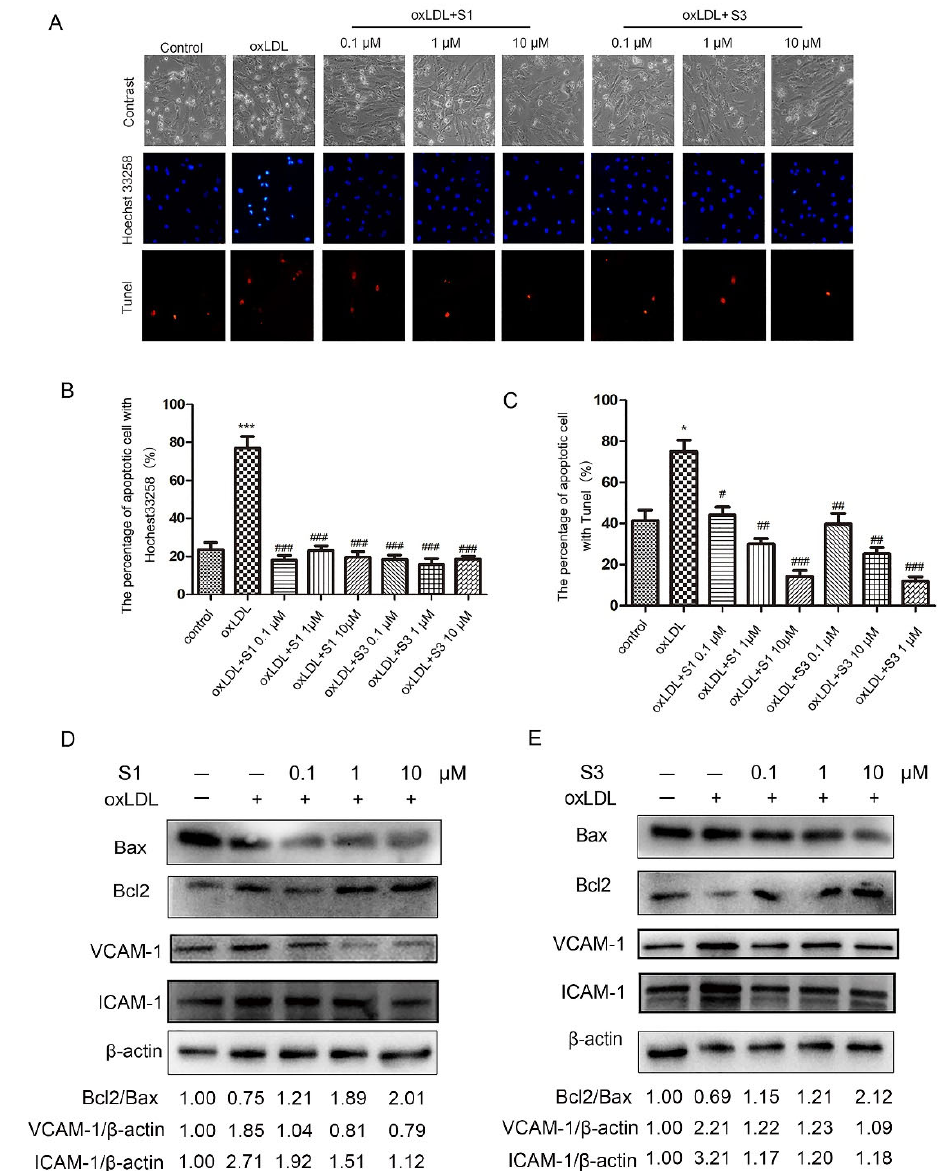
Figure 2. Effect of compounds S1 and S3 on oxLDL-induced apoptosis and the increase in ICAM-1 and VCAM-1 protein level in HUVECs. HUVECs were treated with oxLDL (50 µ g/mL), oxLDL and indicated compounds for 6 h. ( A ) Cell apoptosis was determined by Hoechst 33258 and TUNEL staining (100 × ). ( B , C ) Quantification of percentage of HUVEC apoptosis according to panel ( A ). Data were analyzed using one-way ANOVA with Bonferroni correction. * p < 0.05, *** p < 0.001, vs. control, # p < 0.05, ## p < 0.01, ### p < 0.001 vs. oxLDL, n = 3. ( D , E ) Representative Western blot analysis of the Bax, Bcl-2, VCAM-1 and ICAM-1 protein levels of 3 independent experiments. Densitometry analysis of the representative images performed with ImageJ (NIH) were shown at the bottom, the untreated groups were normalized to